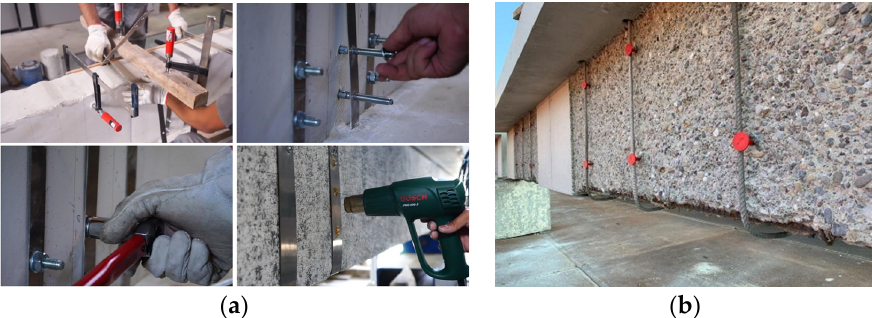
Figure 20. Shear reinforcement of the concrete beam [33,111]: ( a ) external Fe-SMA strips, ( b ) embedding Fe-SMA bars.